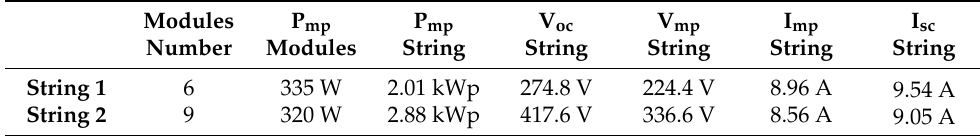
Table 2. Electrical parameters of the PV system strings